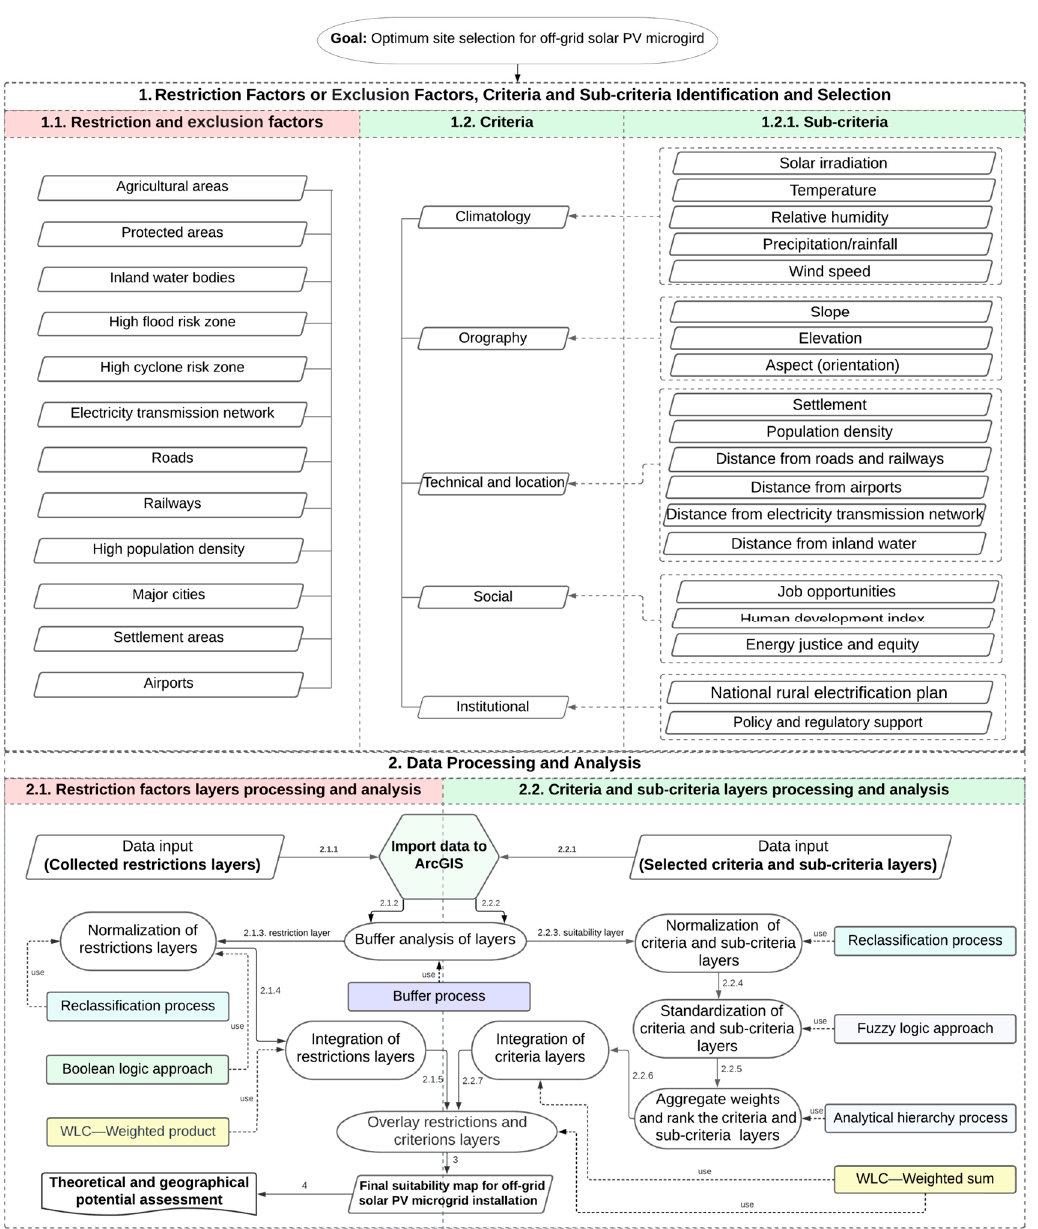
Figure 4. A framework for the proposed methodology.